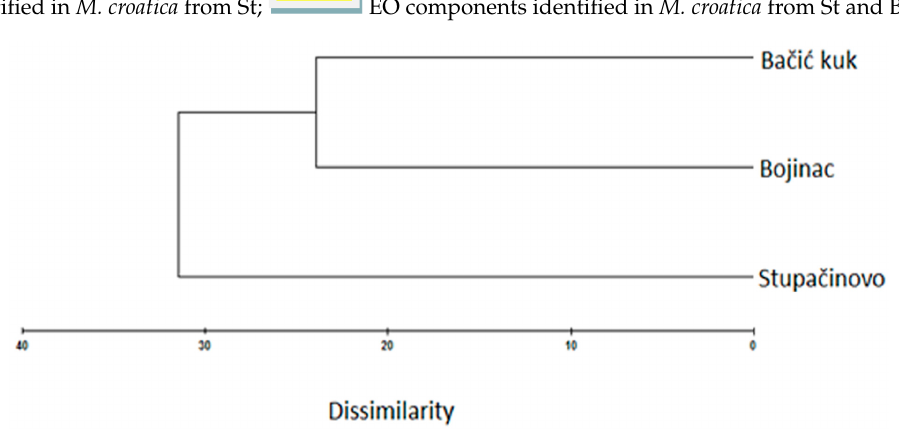
Figure 2. Complete linkage cluster of the essential oil of Micromeria croatica from the localities Bojinac, Ba č i ć kuk and Supa č inovo based on Bray Curtis dissimilarity.